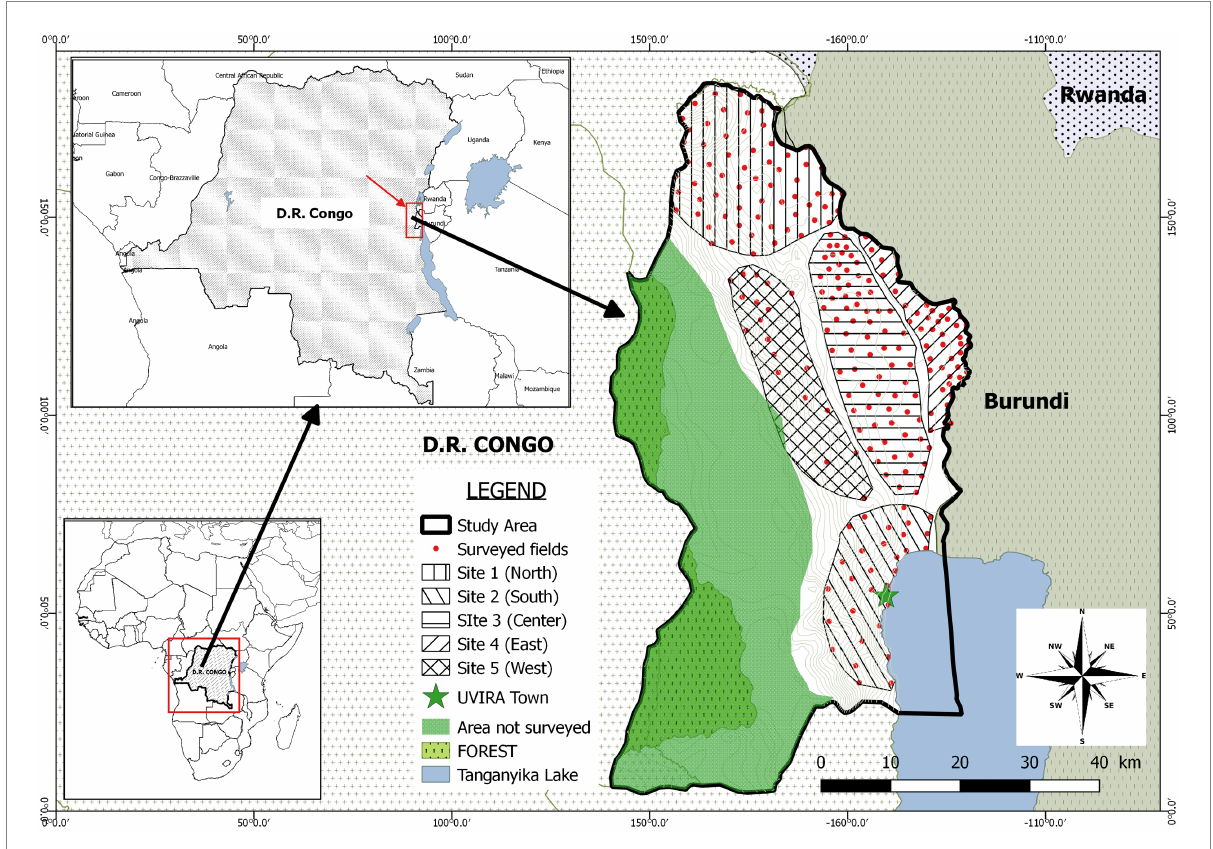
FIGURE 2 Geographic map of the study area showing subdivision into 5 sites. Red dots represent surveyed